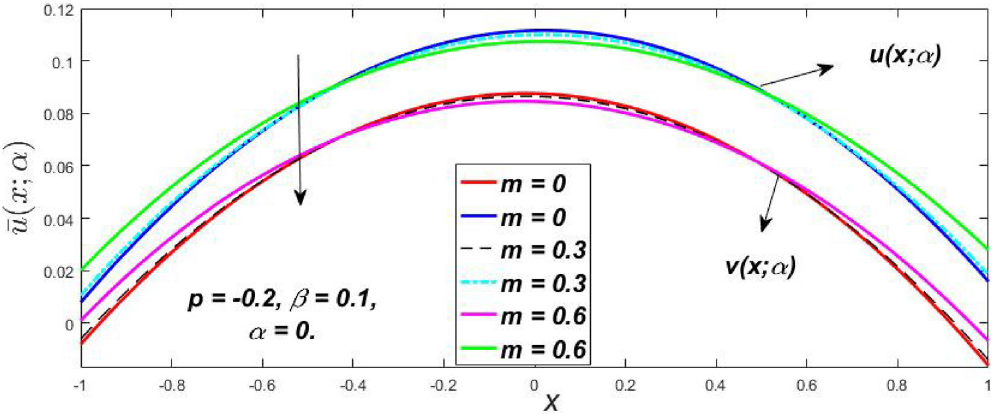
Figure 19. Fuzzy velocity profiles for the impact of m.